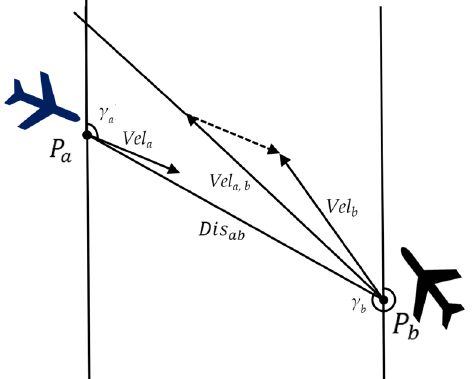
Figure 6. Proximity calculation.